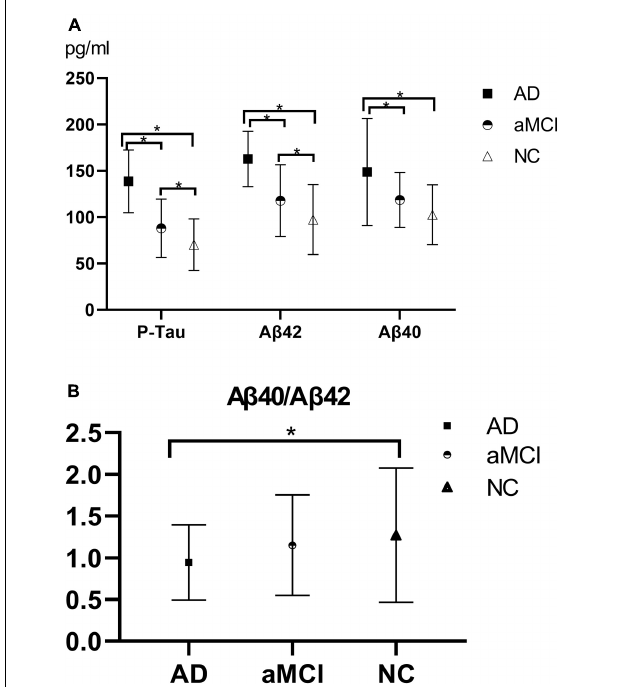
FIGURE 1 | (A,B) Histogram of plasma A β 40, A β 42, P-Tau, and A β 40/A β 42 results in each group. (A) The histogram of plasma A β 40, A β 42, and P-Tau results in each group illustrated that with the progression of the disease, plasma P-Tau, A β 42, and A β 40 all showed upward trends, of which plasma P-Tau, A β 42, and A β 40 in the AD-NC groups and AD-aMCI groups exhibited statistical differences ( P < 0.05); plasma P-Tau and A β 42 had statistical differences ( P < 0.05), whereas there was no statistical difference in A β 40 ( P > 0.05) between the aMCI and NC groups. (B) A β 40/A β 42 showed a downward trend as the disease progressed. The AD and NC group demonstrated a statistical difference ( P < 0.05), while there was no statistical difference between the AD and aMCI groups, and between the aMCI and NC groups ( P > 0.05). AD, Alzheimer’s disease; aMCI, amnestic mild cognitive impairment; NC, normal control; P-Tau, phosphorylated Tau. * P <